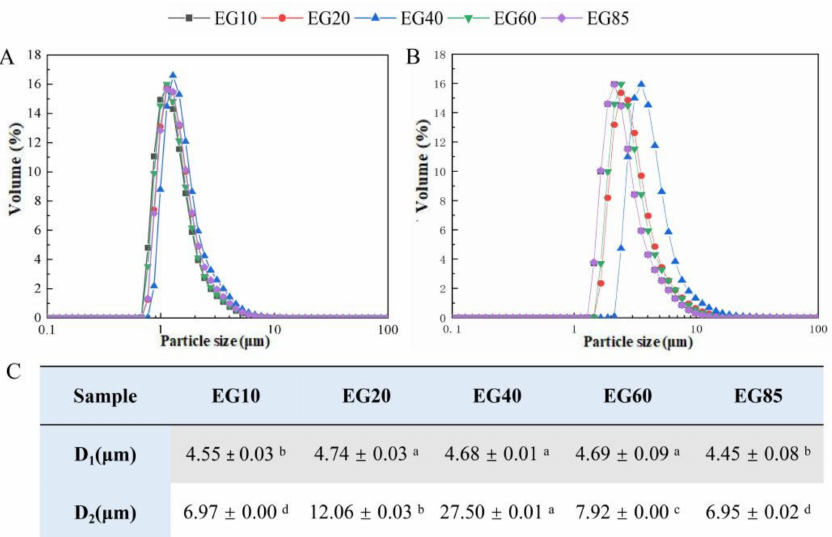
Figure 3. Particle size distribution of acid milk gels ( A ) before and ( B ) after simulated oral process- ing. ( C ) D 1 : volume diameter determined before simulated oral processing; D 2 : volume diameter determined after simulated oral processing. Results are mean ± SD ( n = 3). For each row, a,b,c,d mean that share the same letter within the same parameter were not significantly different ( p ≥